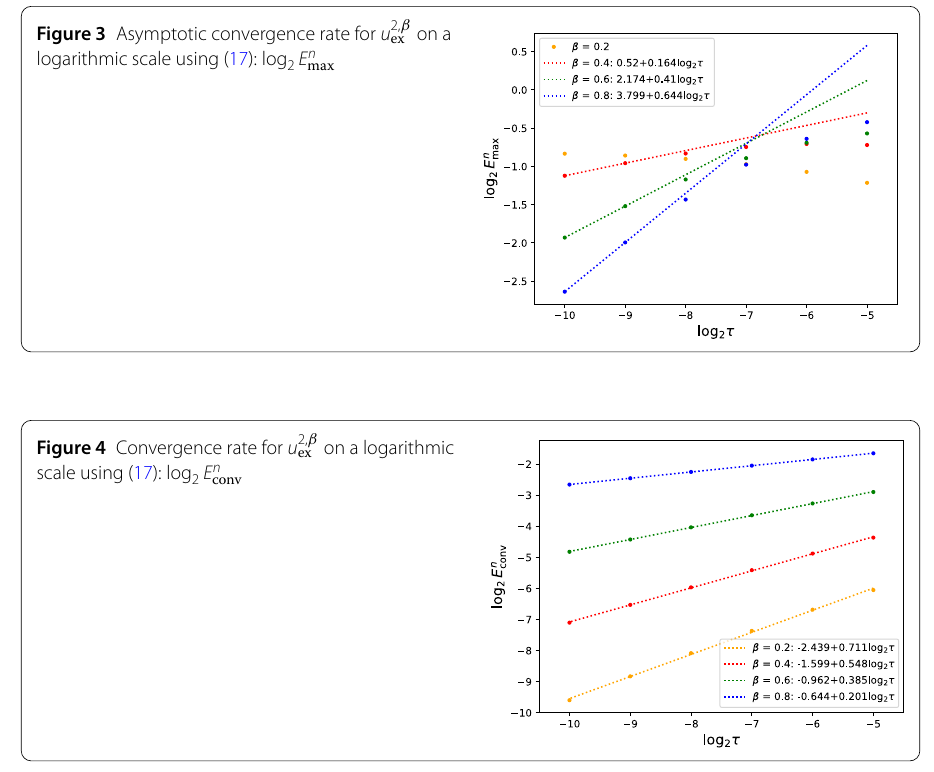
Figure 3 Asymptotic convergence rate for u 2, β ex on a logarithmic scale using (17): log 2 E n max